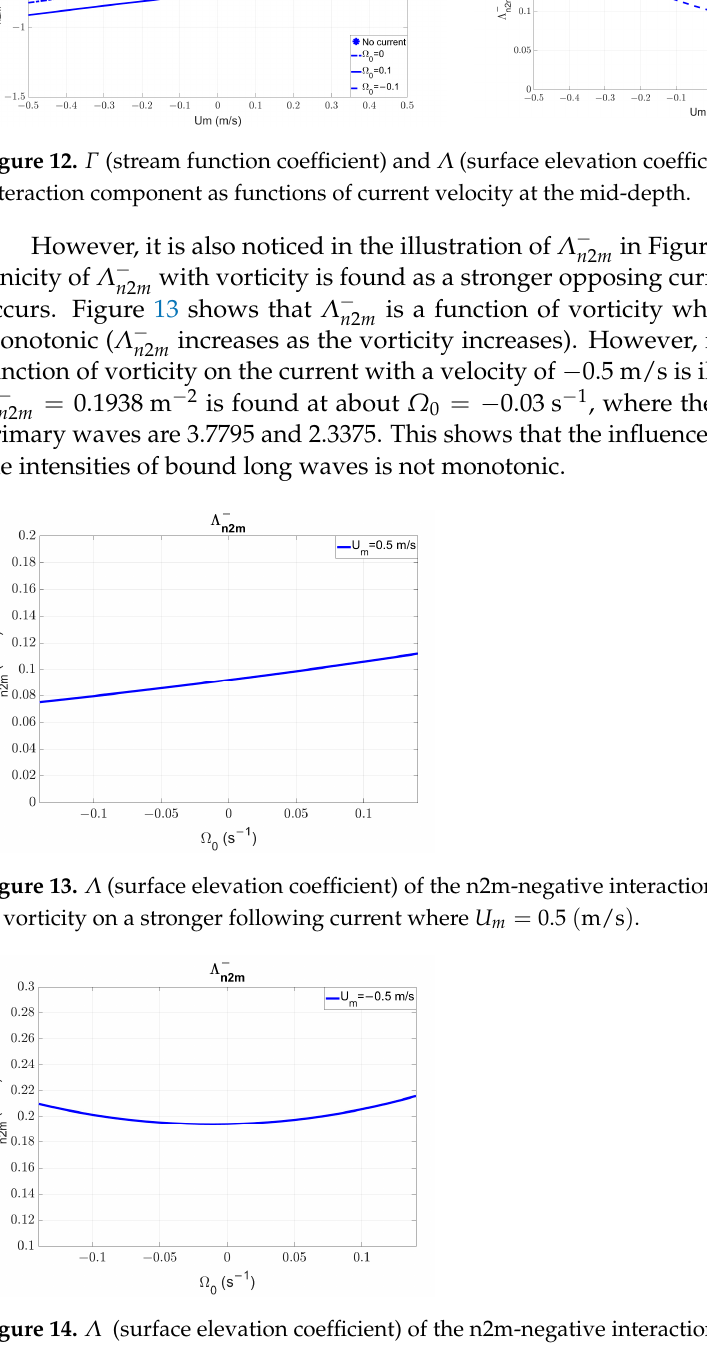
Figure 11. 𝛤 (stream function coefficient) and 𝛬 (surface elevation coefficient) of the nm-negative interaction component as functions of current velocity at the mid-depth.